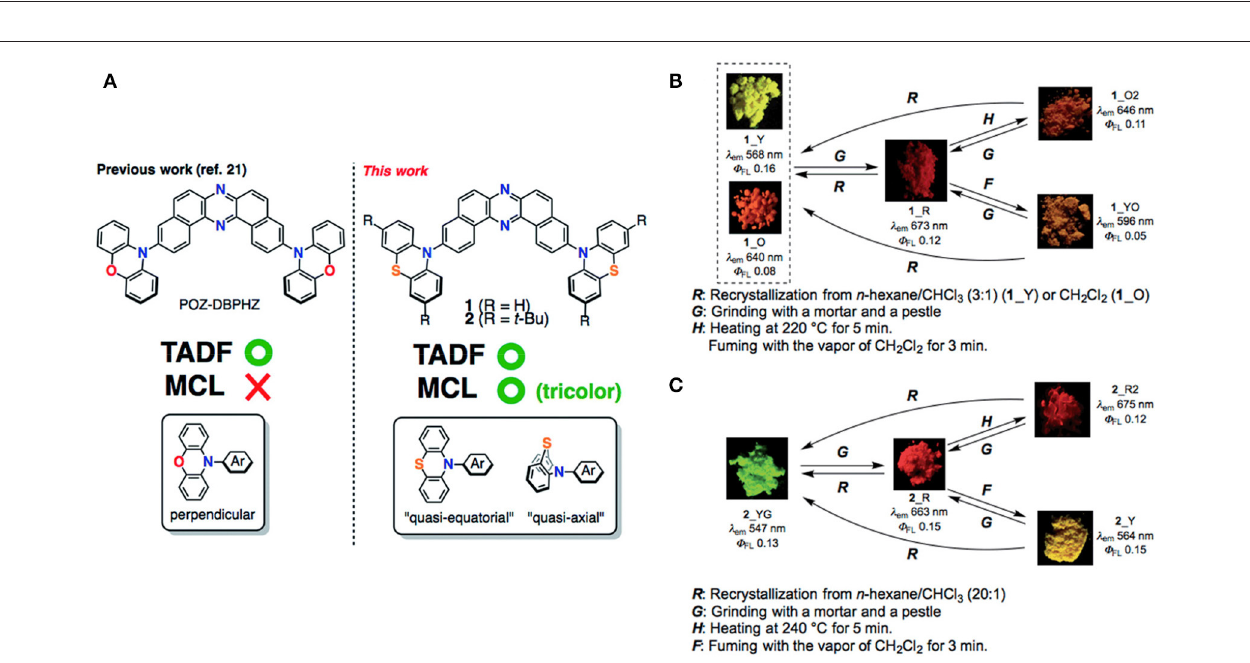
FIGURE 5 | (A) Molecular configurations of DBHZ-cored D-A-D triads. (B,C) Schematic representation of mechanoluminescence property of 1 and 2, respectively, under a 365nm UV lamp. Reproduced with permission from Okazaki et al. (2017). Copyright © The Royal Society of